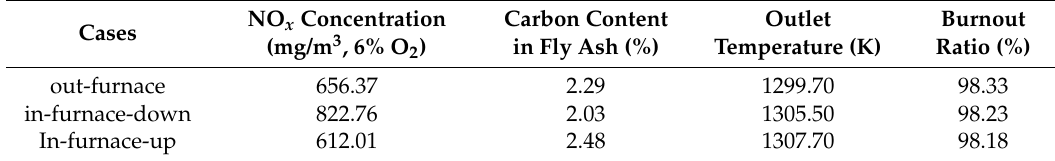
Table 4. Some indicators at the furnace outlet under various injection strategies of